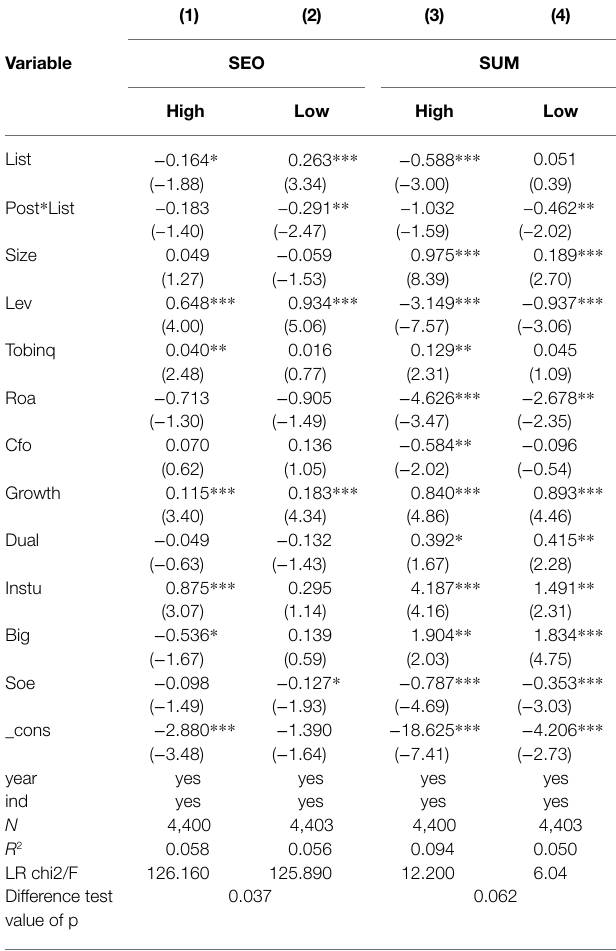
TABLE 4 | Deregulation of short selling and private placement of companies: the degree of equity checks and balances.